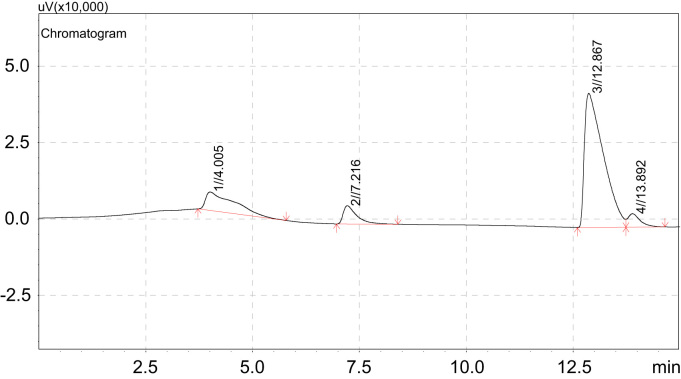
Sample standard.